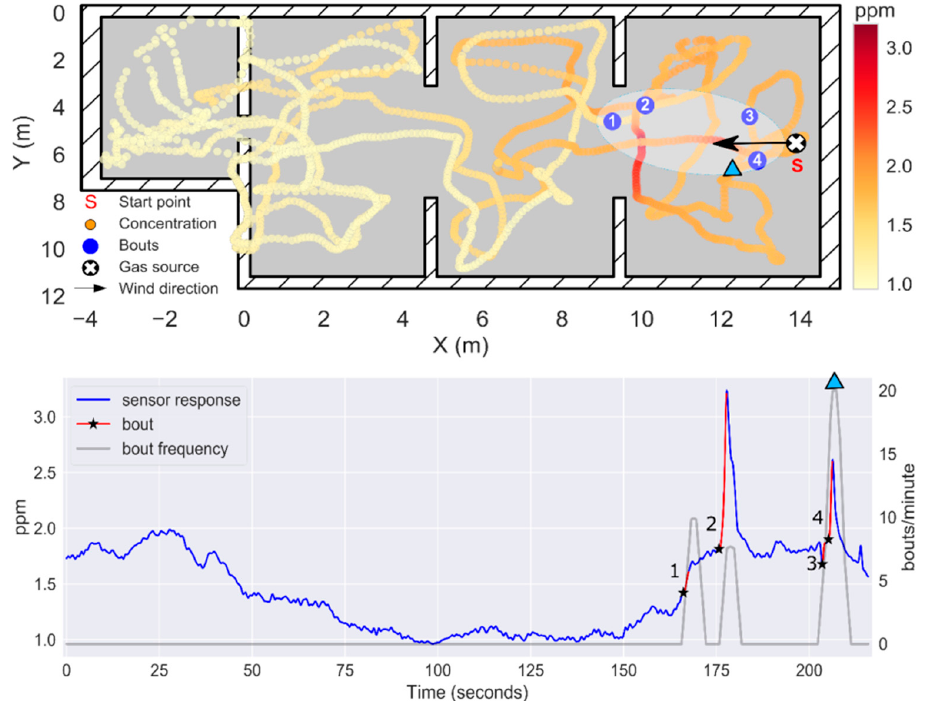
Figure 19. Results of Experiment 2 when b thr is increased to 0.18 ppm/s. ( top ) 2D map of the instantaneous concentration (ppm), with odor hits represented by blue circles. A hand-drawn ellipse outlines the approximate plume shape based on the location of bouts. ( bottom ) Temporal evolution of the instantaneous concentration (ppm), with detected bouts highlighted in red (the black star indicates the start of the bout). The bout frequency (gray line) is computed using a sliding window of 5 s. The maximum bout frequency is indicated by a blue triangle.